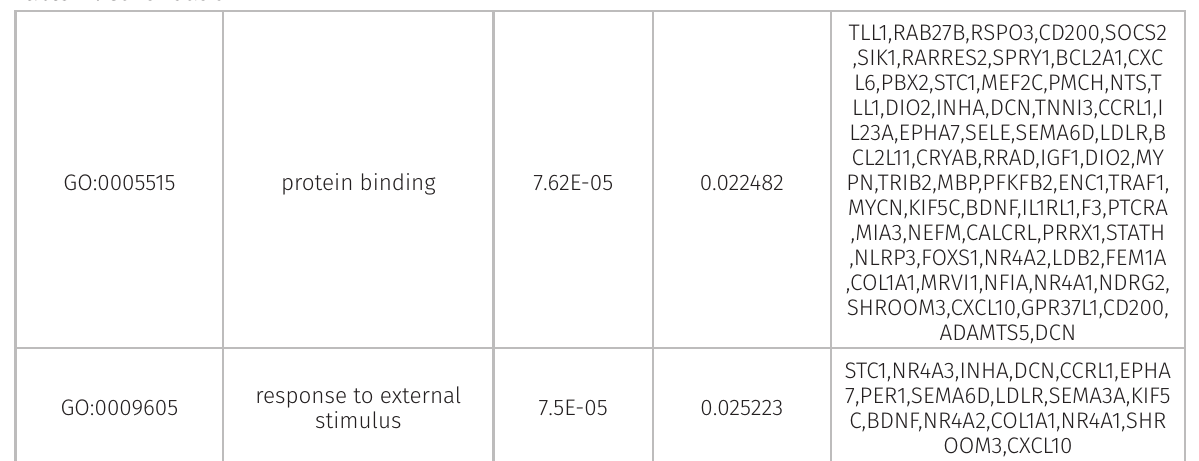
Figure 3. The heat map of differentially expressed genes. Every column represents a sample, and each line represents a single gene. Different colours indicate different expression levels. The red, green and black indicate upregulation, downregulation and no change, respectively. C: control, S: